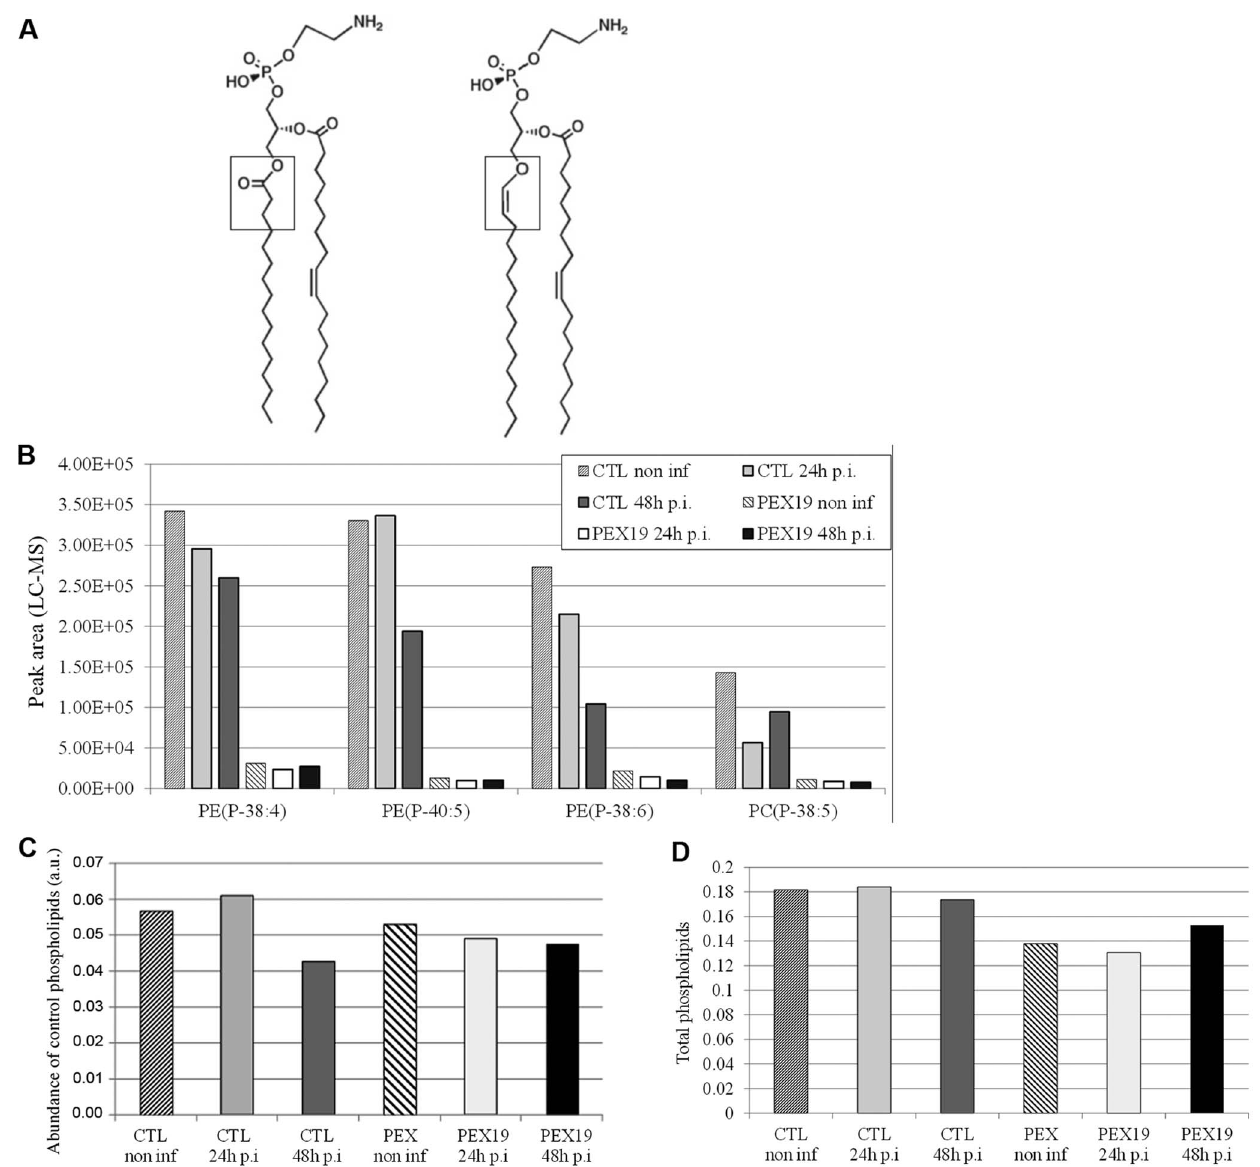
Figure 4. Many plasmalogens decrease upon infection. A- Structure of plasmalogens. Phosphatidylethanolamine (left) and the plasmalogen version of phosphatidylethanolamine (right) are depicted. The plasmalogen variant contains a long chain alcohol in place of a fatty acid and has a double bond between the first two carbons of the alcohol (1-O-alkenyl-2-acyl- sn -glycero-3-phosphoethanolamine; plasmenylethanolamine). B- Example of plasmalogens abundant in the non-infected control fibroblasts. Putative plasmalogens were identified based on their predicted formula as C x H 2x–2y NO 7 P (where y=the number of double bonds in the fatty acid) after ICR-FT/MS analysis (mass error , 100 parts/billion, MassTRIX [46]), and on their sensitivity to acid hydrolysis. Lipid species fulfilling these criteria were either missing or severely reduced in peroxisome-deficient cells (‘‘PEX19’’) compared to control fibroblasts (CTL), confirming that they are plasmalogens. Note that, globally, plasmalogen content decreased during infection, most notably at the later time point. Identification of plasmalogens was performed on samples from a single experiment. C- Abundance of control phospholipids. Phospholipids that gave the highest signal intensity in the ICR-FT/MS (corresponding to C42H82NO8P) were arbitrarily chosen as control. D- Total phospholipids detected with ICR-FT/MS. The intensities of all annotated phospholipids (mass error , 1 ppm) were summed and normalized to the total sum of intensities in the sample. The data in C and D are representative of two independent experiments.